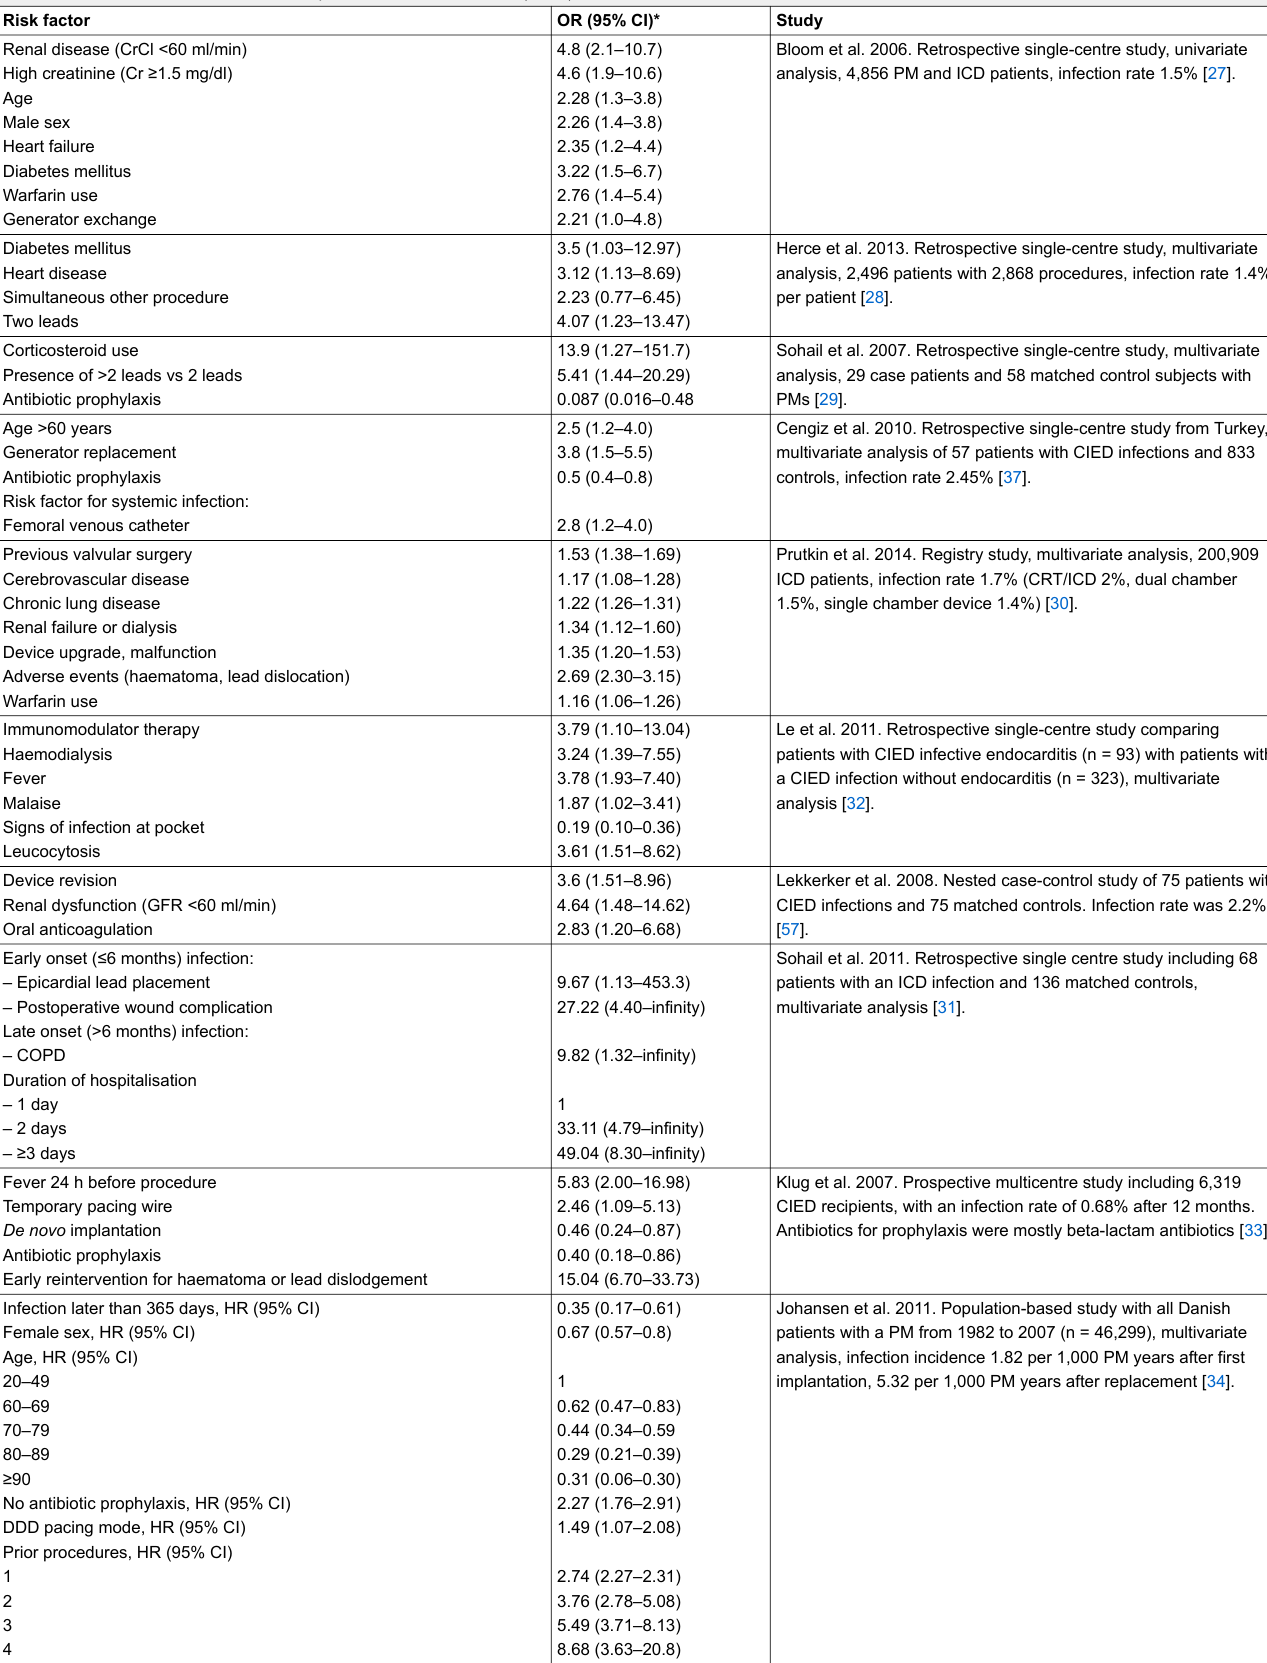
Table 1: Risk factors for cardiovascular implantable electronic device (CIED)